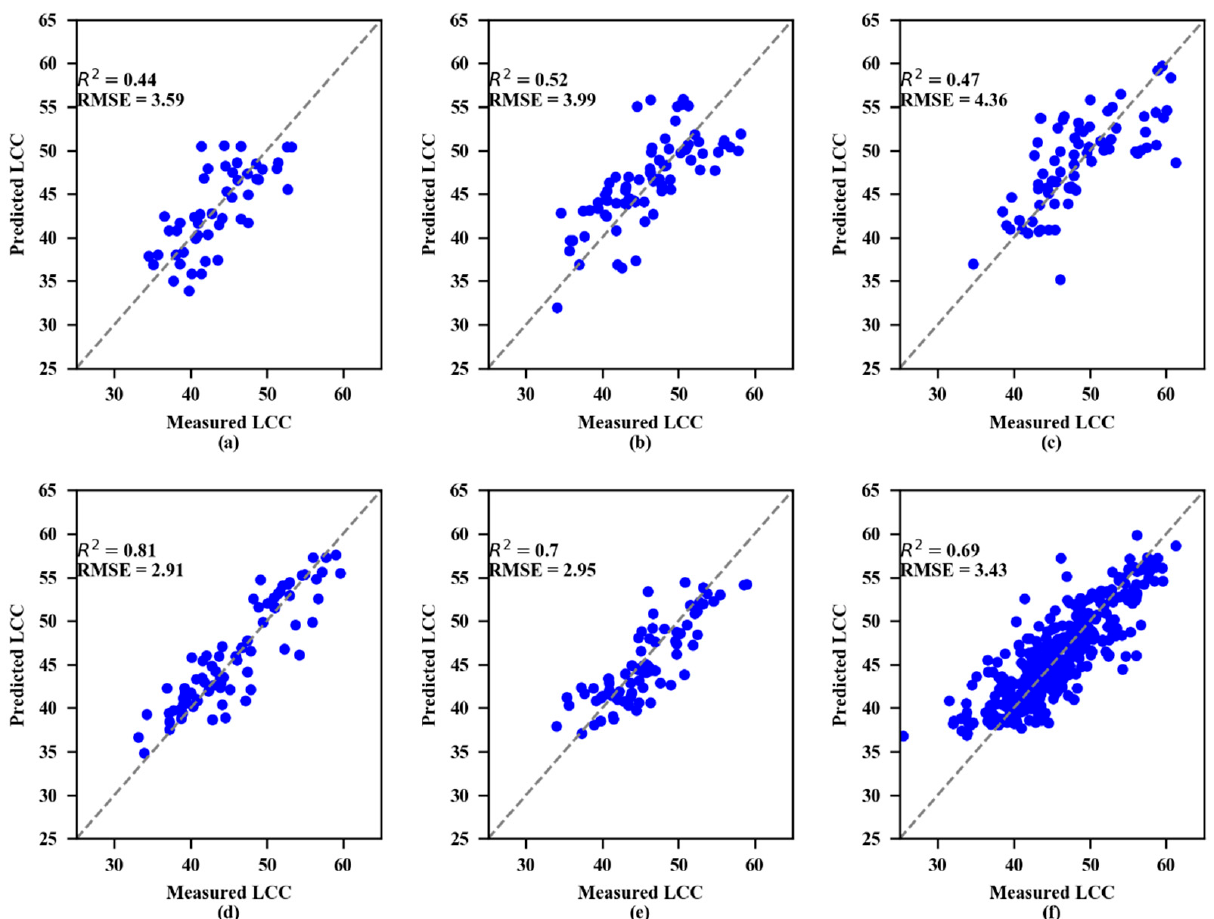
Figure 6. Measured and predicted LCC along the 1:1 line in the standalone validation datasets of the support vector regression (SVR) model. ( a ) 1st growth stage, ( b ) 2nd growth stage, ( c ) 3rd growth stage, ( d ) 4th growth stage, ( e ) 5th growth stage, and ( f ) All growth stages.